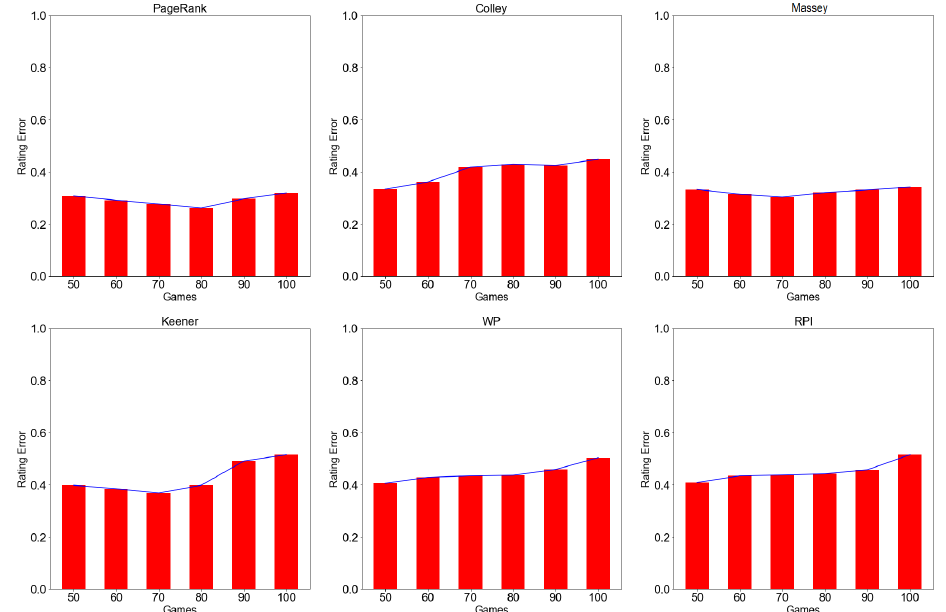
Figure A2. Rating error at different window times for PageRank, Colley, Massey, Keener, WP, and RPI methods by the expanding window approach. A lower E φ ( t ) indicates high prediction power and better rating performance, while larger E φ ( t ) indicates low prediction power and hence low rating